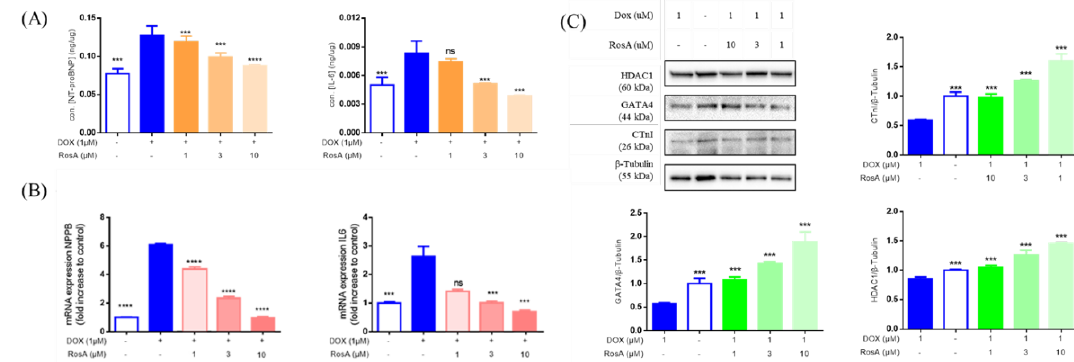
Figure 8. The myocardial protection of RosA in a Dox-induced hiPS-CMs injury model. ( A ) The levels of NT-proBNP and IL-6 were measured by ELISA. ( B ) The mRNA levels of NPPB and IL6 were evaluated using real-time PCR, with GAPDH as an internal control. ( C ) The levels of myocardial protection proteins, such as HDAC1, GATA4, and CTnI, were measured by Western blot, with β -tubulin as an internal control. *** p < 0.001, **** p < 0.0001, ns: no significant di ff erence. 1 µ M Dox-treated was the model group; 0.25% DMSO-treated was the negative control group, compared with the model group. Results are expressed as mean ± SD ( n = 3).